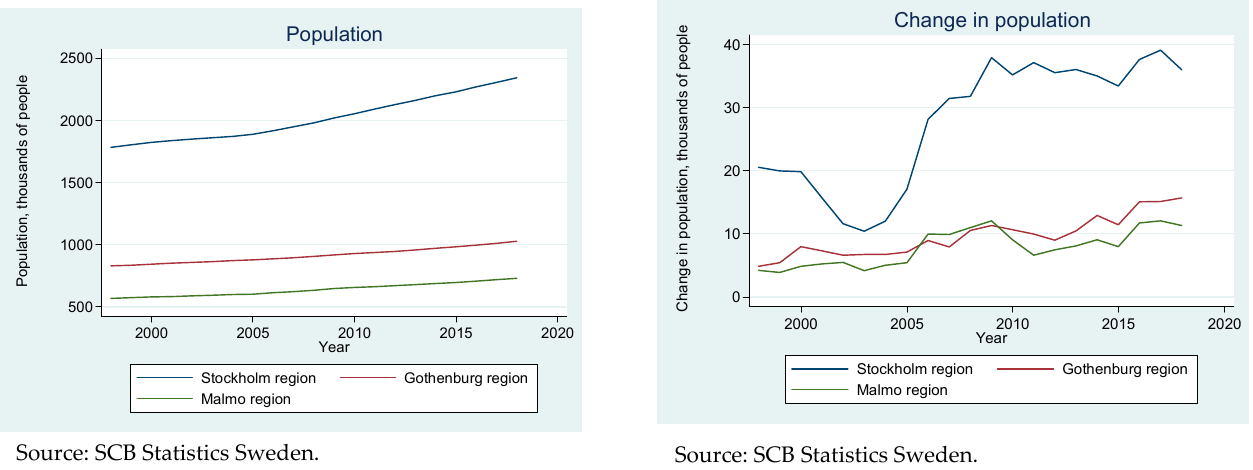
Figure 7. Population dynamics in the three largest urban areas in Sweden: ( a ) population; ( b ) change in population.